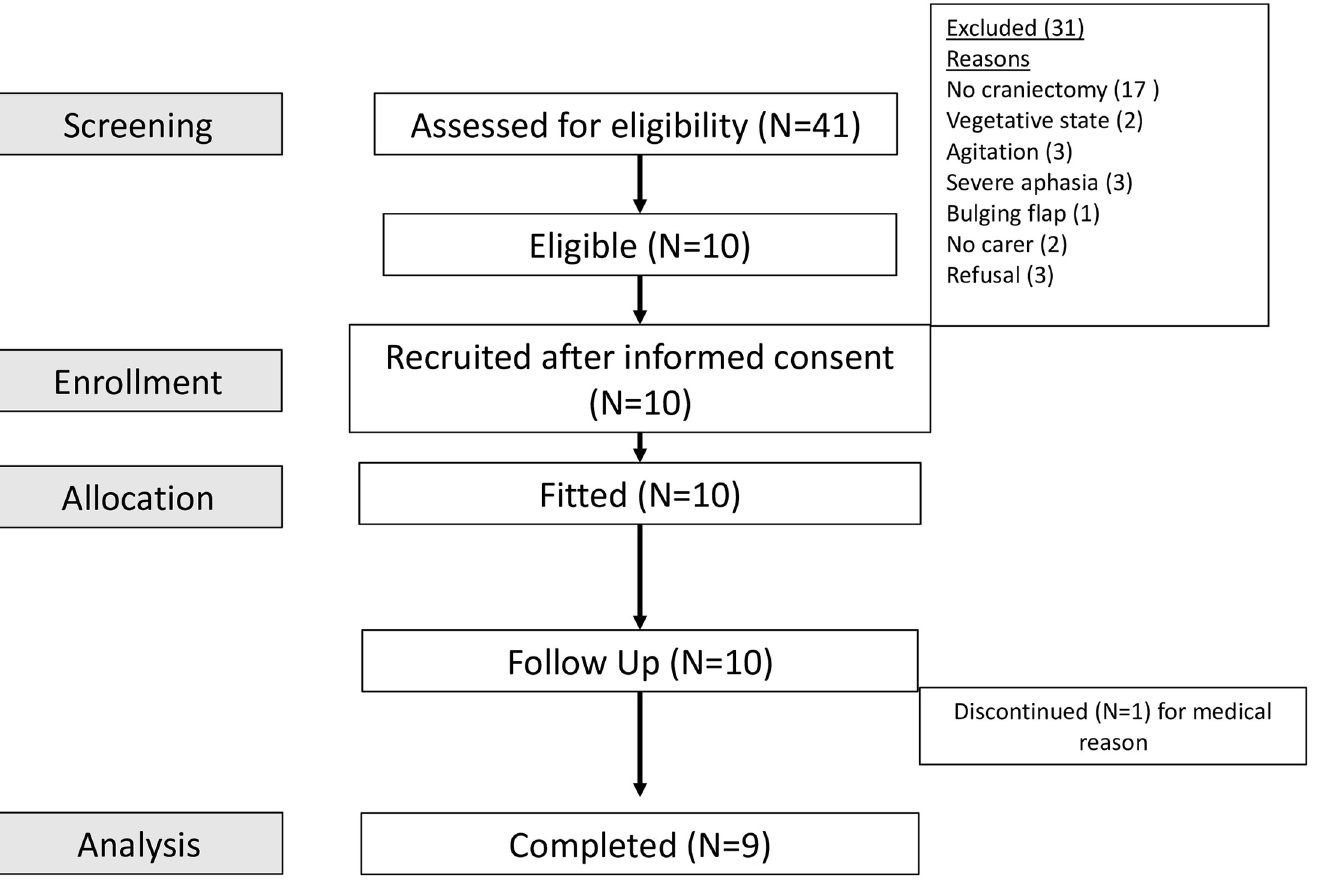
Fig 2. Subject recruitment flow